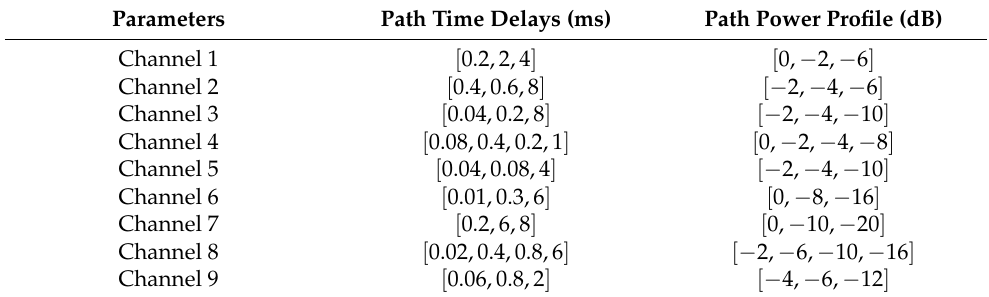
Table 3. Delay and power profiles for multipath Rayleigh fading channels for individual sens- ing nodes. Parameters Path Time Delays (ms) Path Power Profile (dB) Channel 1 [ 0.2,2,4